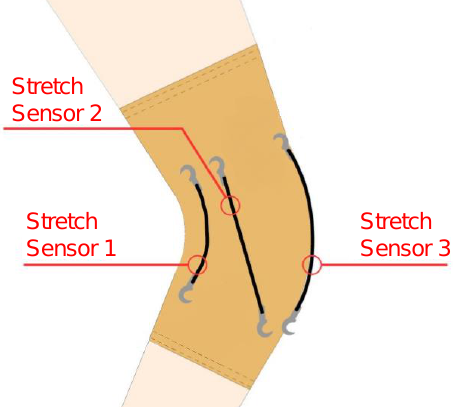
Figure 3. Position on the knee of the sensors evaluating knee laxity.